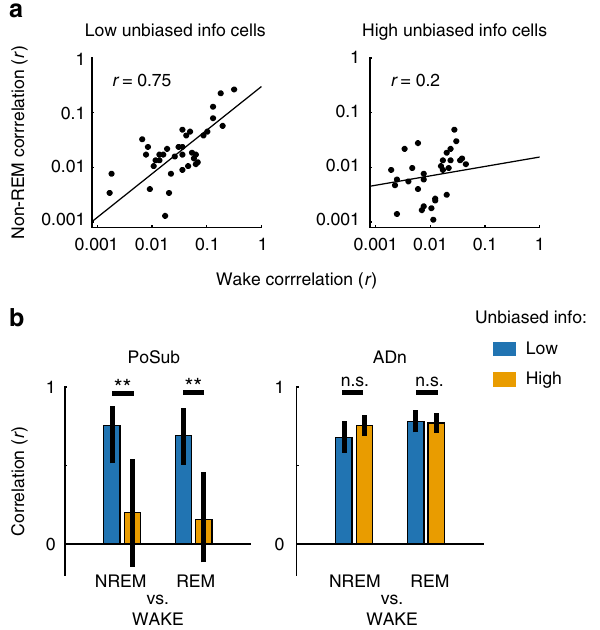
Fig. 4 Functional connectivity of spatially related cells is not rigid. a Left, pairwise neuronal correlation during non-REM vs. wake for PoSub cell pairs with low unbiased spatial information (bottom 33% percentile); right, same for cell pairs conveying high unbiased spatial information (top 33% percentile). b Left, cross-brain states correlations (non-REM vs. wake and REM vs. wake) in the PoSub for neuron pairs conveying low (blue) and high (orange) unbiased spatial information; right, same for ADn cell pairs. ** p < 0.01; error bars indicate 95% con fi dence interval